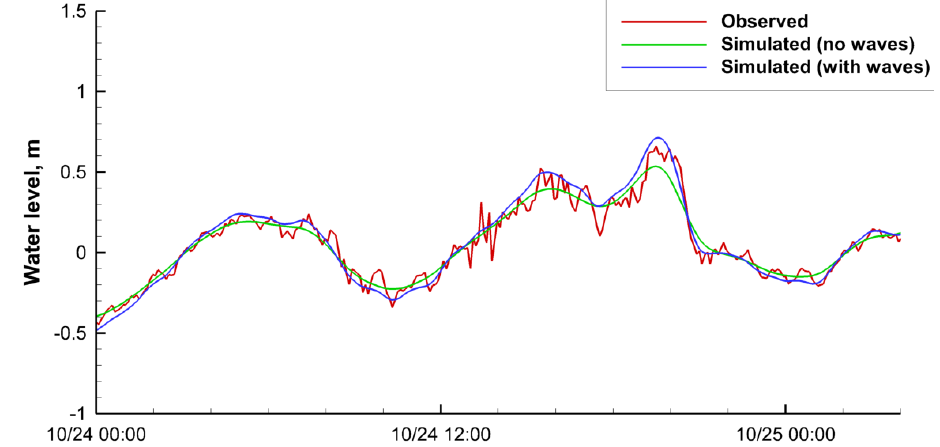
Figure 17. A comparison between simulated (hindcast) and observed water levels at the Trident Pier Station during Hurricane Wilma (2005).